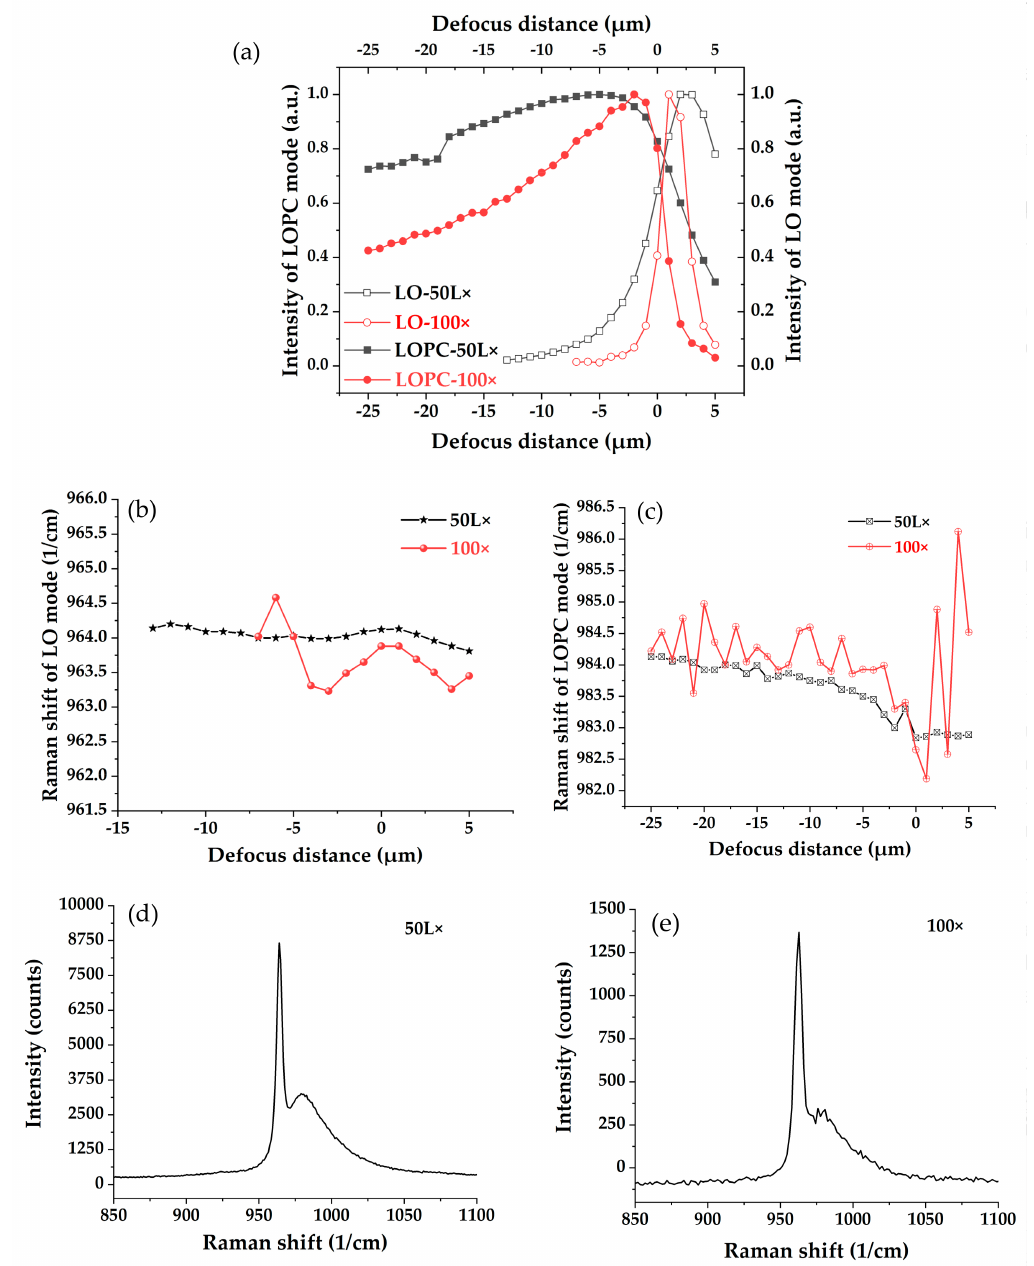
Figure 5. ( a–c ): Variation of peak intensity ( a ) and position ( b , c ) of sample Q1 with lenses of 50L × and 100 × using a 100 µ m pinhole. The step of depth profiling is 1 µ m. ( d ) Raman spectrum of Q1 when focusing on the sample surface using the 50L × lens. ( e ) Raman spectrum of Q1 when focusing on the sample surface using the 100 × lens. The fitting procedure always converged and resulted in a R 2 (coe ffi cient of determination) in the range of 0.973–0.998. In the whole range of depth profiling, the standard error of the LOPC mode position is between 0.19–0.25 cm − 1 and for LO mode, the standard error of peak position is between 0.01–0.25 cm − 1 (Supplementary